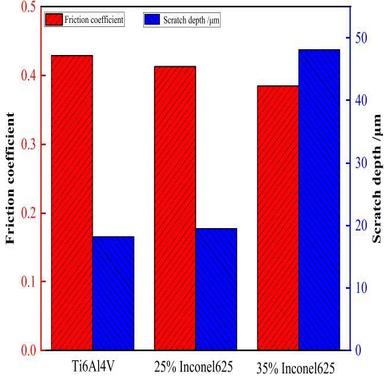
Variation in friction coefficient and scratch depth for layers with different amounts of Inconel 625.